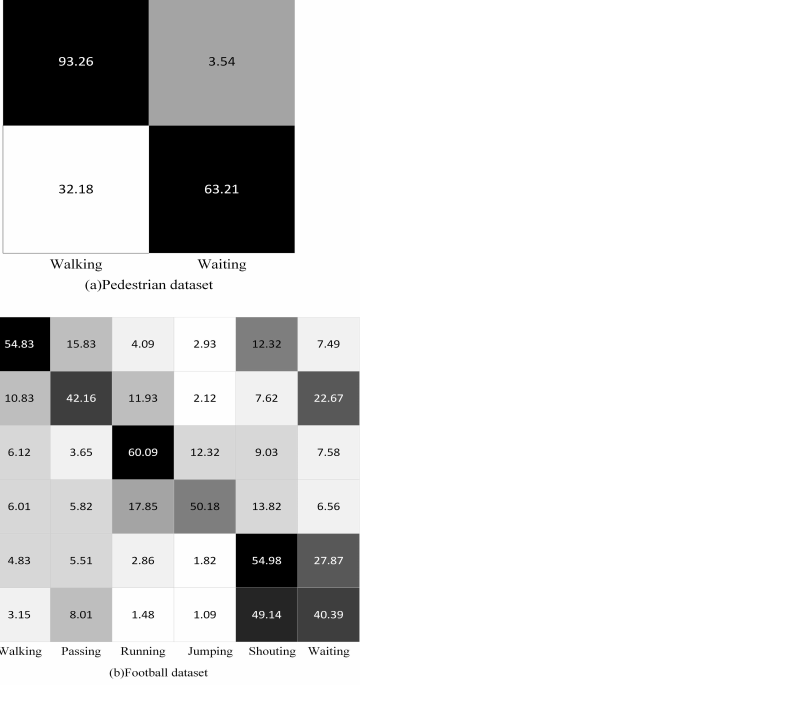
Figure 8. The confusion matrix of two data sets.